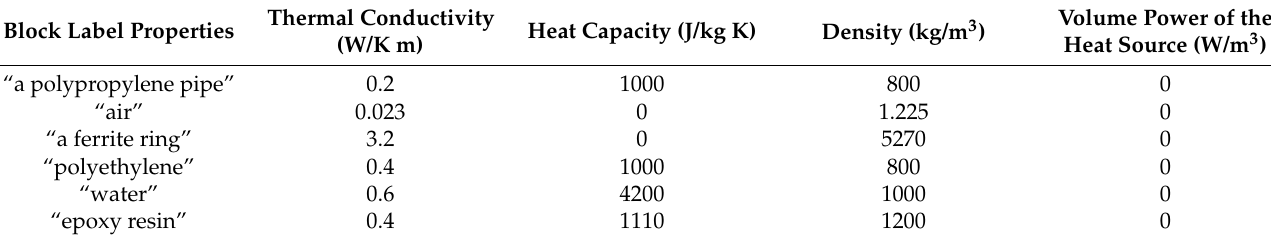
Figure 7. Boundary label properties: ( a ) boundary with the environment, and ( b ) pipe and water boundary. The physical properties of the labels are demonstrated in Table 2. Table 2. Physical properties of the labels.